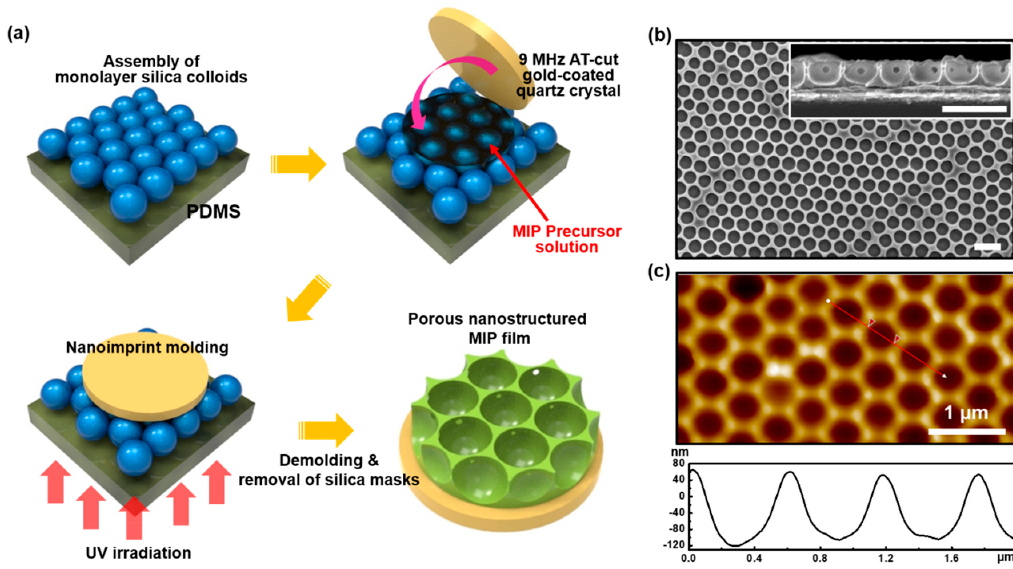
Figure 2. ( a ) Fabrication process of a porous MIP ( p -MIP) film using a 2D silica colloidal monolayer as a master mold, ( b ) SEM (inset is a cross-sectional image), and ( c ) AFM images (line profilometry is included below the AFM image) of the p -MIP film. All the scale bars in ( b ) are 1 µm. As a control sample, the pl -MIP film showed a frequency change of − 187 ± 7 Hz, corresponding to the mass per unit area (ng/cm 2 ) of 1020 ± 38. However, the higher sensing response ( Δ f = − 283 ± 7 Hz ≈ 1543 ± 38 ng/cm 2 ) appeared on the p -MIP films due to the specific recognition toward the more accessible templated cavities of the nanostructured porous arrays. In other words, this could be explained by an increase in the effective surface area as a result of the nanoporous structuring process. It was comparatively favorable for the rapid transport of 2,4-D target molecules in imprinted film and allowed the specific recognition of 2,4-D over the nanocavities distributed over the entire thin film’s surface. In addition, the hydroxyl groups on the surface of the silica colloids are involved in complex formation during the polymerization process. For NIP films, nonspecific template adsorption on the surface occurred due to the unrecognizable cavities in the polymer matrix, representing significantly lower sensing responses ( Δ f = − 64 ± 3 Hz and − 92 ± 2 Hz) on the pl -NIP and p -NIP films. When the formation process of MIP and NIP films is considered, the conformation of the polymer matrix in the formed MIP film may be affected by existing interactions with the template, and template recognition in the cavities preferentially occurs in the rebinding process due to the existing affinity and template specificity. However, nonspecific binding on the surface of MIP films, as a minor effect, also influences the frequency change in the rebinding process. As shown in Figure S4, using a nonextracted pl -MIP film, we explored a rebinding process on the same 2,4-D solution to investigate nonspecific adsorption. Even though the imprinted templates were fully occupied in the cavities, 2,4-D molecules were nonspecifically adsorbed on the surface, indicating that the lower frequency change of -28 ± 8 Hz appears in comparison to that of the pl -NIP film. Therefore, in the case of p -MIP films, the conformation of imprinted films can be determined from the effects of the